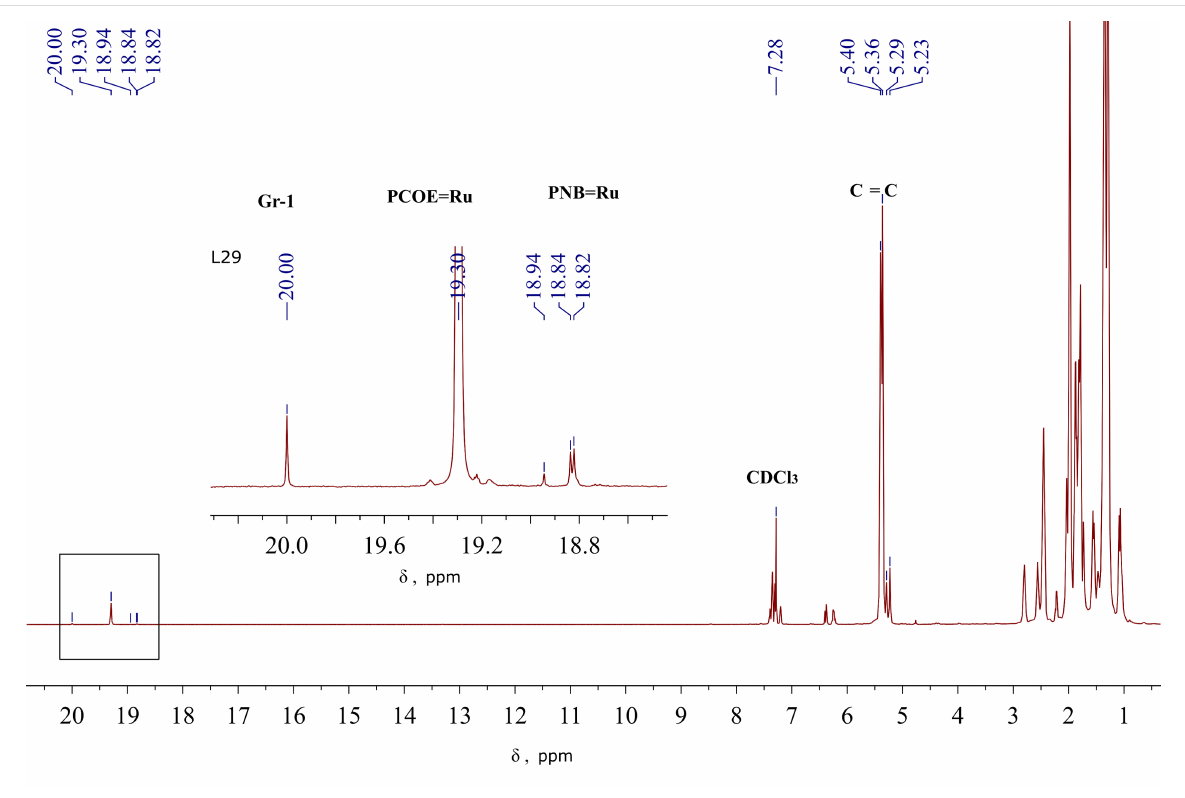
Figure 7: The 1 H NMR spectrum recorded after 24 h of the reaction between PCOE, PNB, and Gr1 in CDCl 3 . The carbene signals are enlarged in the inset [90].